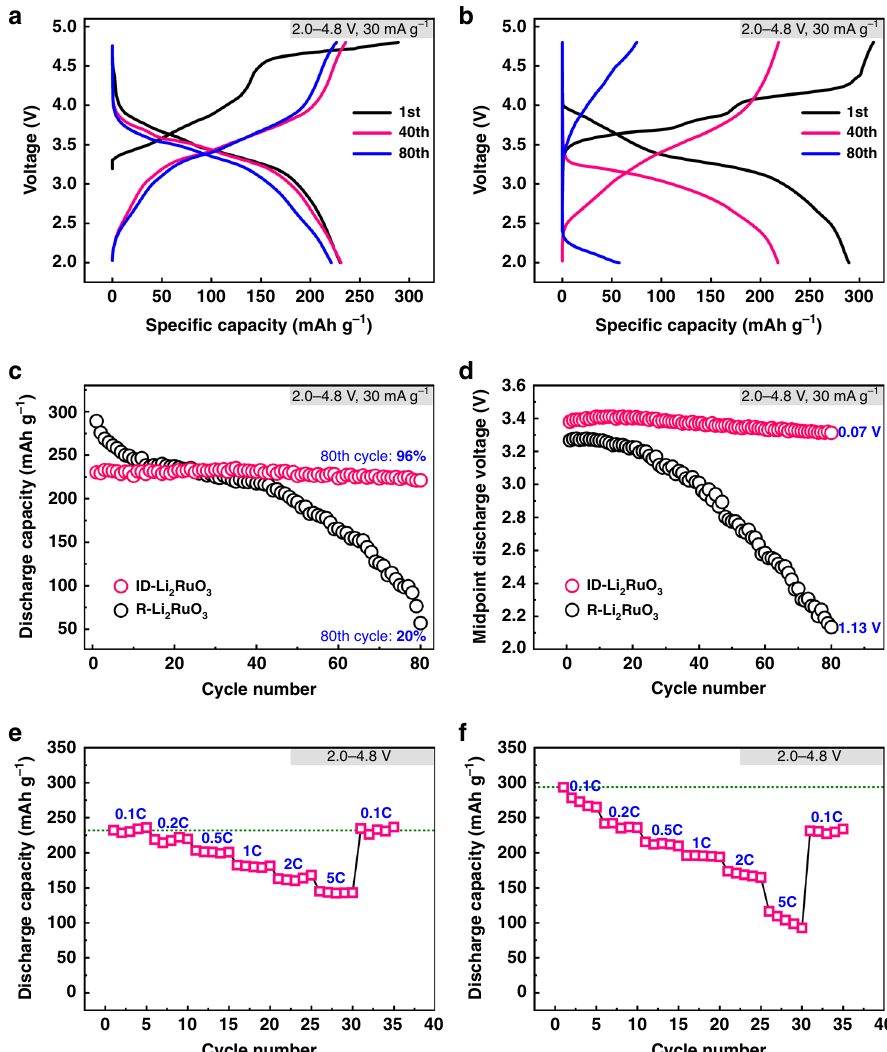
Fig. 4 The comparative electrochemical performance. a , b The charge − discharge pro fi les of ID-Li 2 RuO 3 ( a ) and R-Li 2 RuO 3 ( b ). c Cycling performance of ID-Li 2 RuO 3 and R-Li 2 RuO 3 in the voltage range of 2.0 – 4.8 V at a current density of 30 mA g – 1 (0.1 C). d Midpoint discharge voltages of the ID-Li 2 RuO 3 and R-Li 2 RuO 3 during cycling. e , f The progressive charging and discharging of the ID-Li 2 RuO 3 ( e ) and R-Li 2 RuO 3 ( f ) electrode in serial stages at various current rates from 0.1 C (30 mA g – 1 ) to 5 C (1500mA g – 1 ) in the voltage range of 2.0 – 4.8